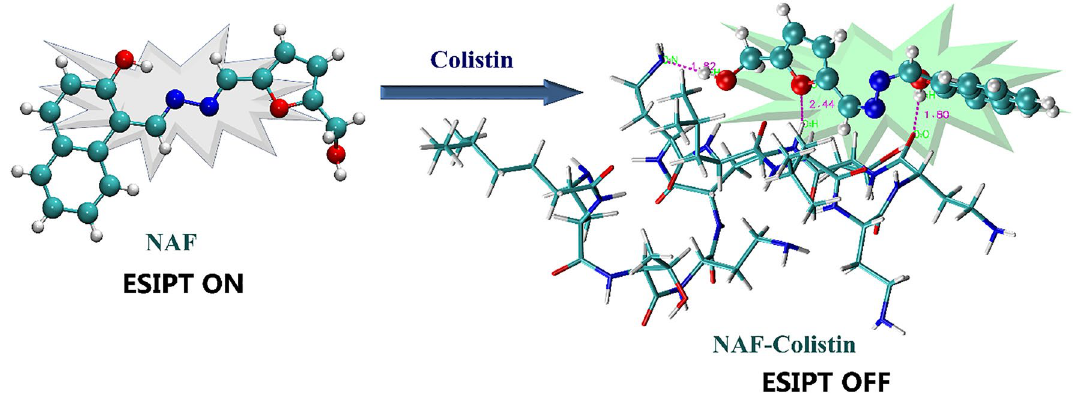
Figure 2. Binding mechanism of NAF with